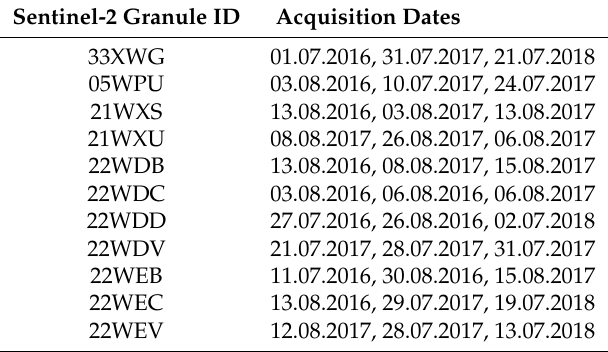
Table 2. Dates of Sentinel-2 acquisitions used for areas with independent validation (see also Table